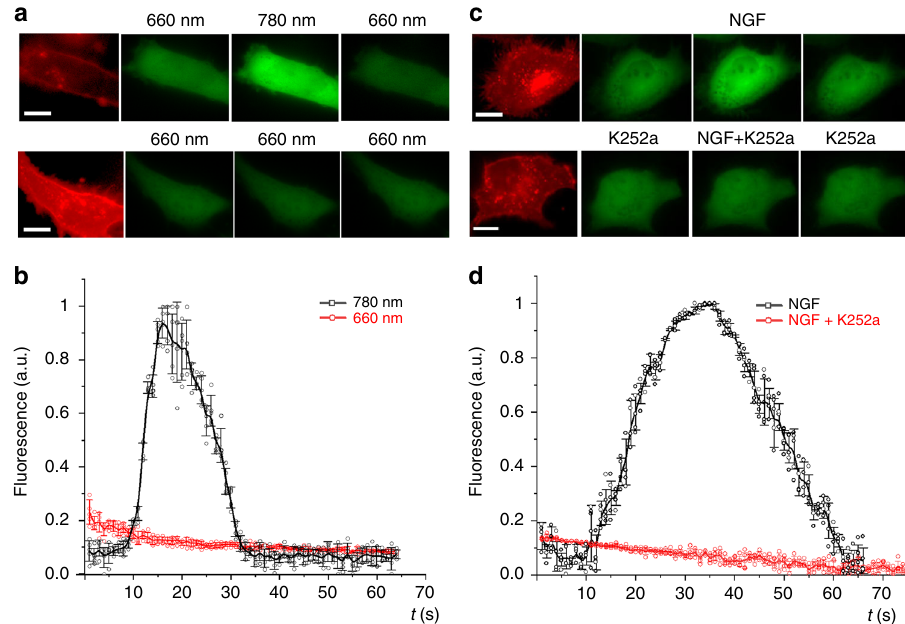
Fig. 5 Activation of calcium signaling by Dr-TrkA. a Images of HeLa cells co-expressing mCherry-Dr-TrkA and GCaMP6m. Upper row: cells under constant 660 nm light (0.5 mW cm − 2 ) were stimulated with 20 s pulse of 780 nm light (0.5 mWcm − 2 ). Bottom row: the same cells under constant 660 nm light (0.5 mW cm − 2 ). Note the decrease of cellular calcium in the last images. Scale bar, 10 μ m. b Changes of GCaMP6m fl uorescence for Dr-TrkA-expressing cells either stimulated by 780 nm light for 20 s (black line) or kept under 660 nm light (red line). c Images of HeLa cells co-expressing TrkA-DsRed2 and GCaMP6m. Upper row: cells before and after addition of 50 ng ml − 1 nerve growth factor (NGF). Bottom row: cells stimulated with NGF in the presence of 100 nM of K252a. Note the decrease of cellular calcium in the last images. Scale bar, 10 μ m. d Changes of GCaMP6m fl uorescence upon stimulation of the cells with NGF in the absence (black line) or presence of K252a (red line). Error bars represent s.d., n = 3